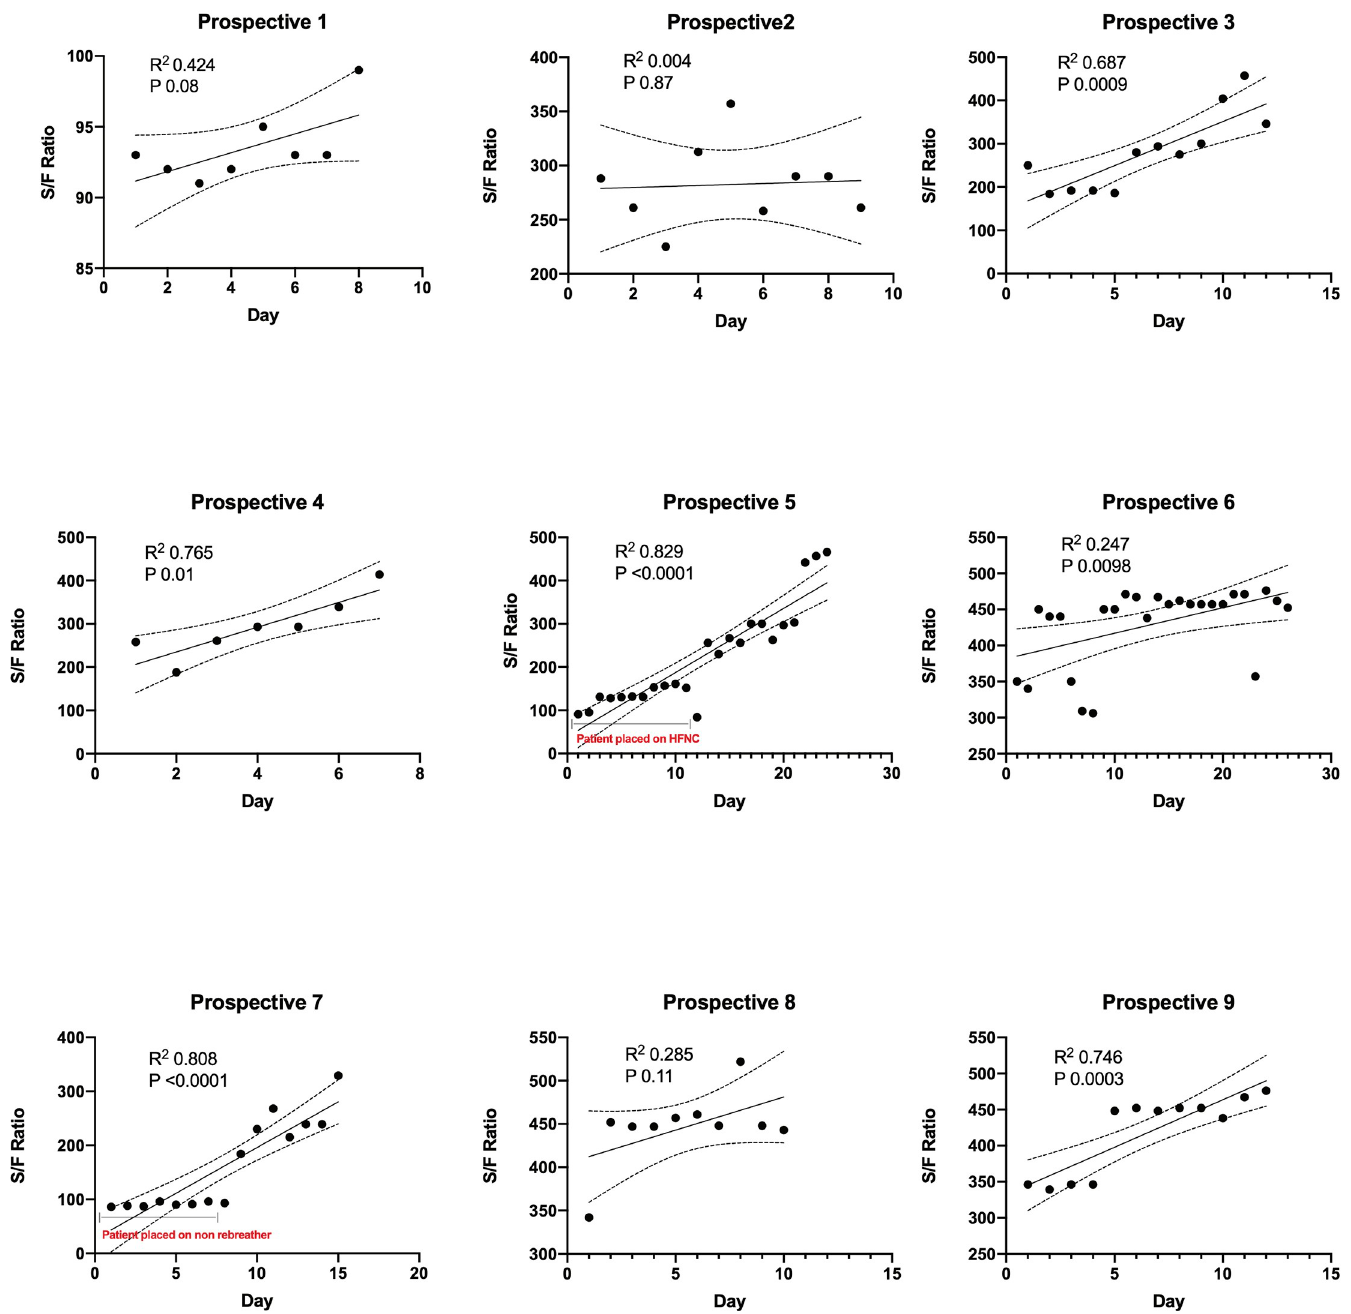
Fig 2. Linear regression of S/F ratio for each patient that completed a minimum of 7 days of losartan in the prospective cohort from the start of losartan during hospitalization until the time of discharge or discontinuation of losartan. HFNC, High Flow Nasal Cannula. Data expressed as daily S/F ratio, with best fit line (R 2 , slope with 95% confidence interval, P-value for statistically significant non-zero